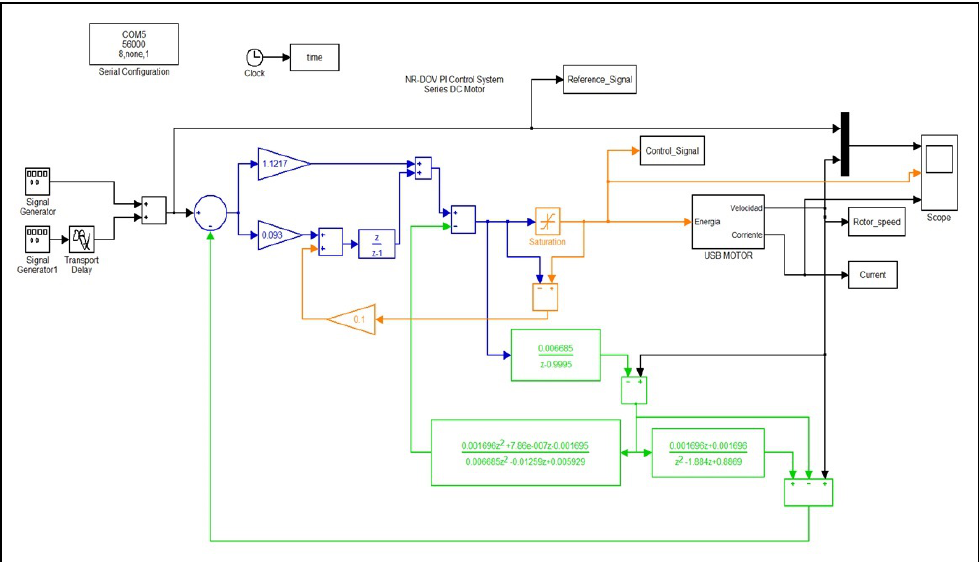
Figure 18. NRDOB_PI plus “anti-windup” control system for the series DC motor.